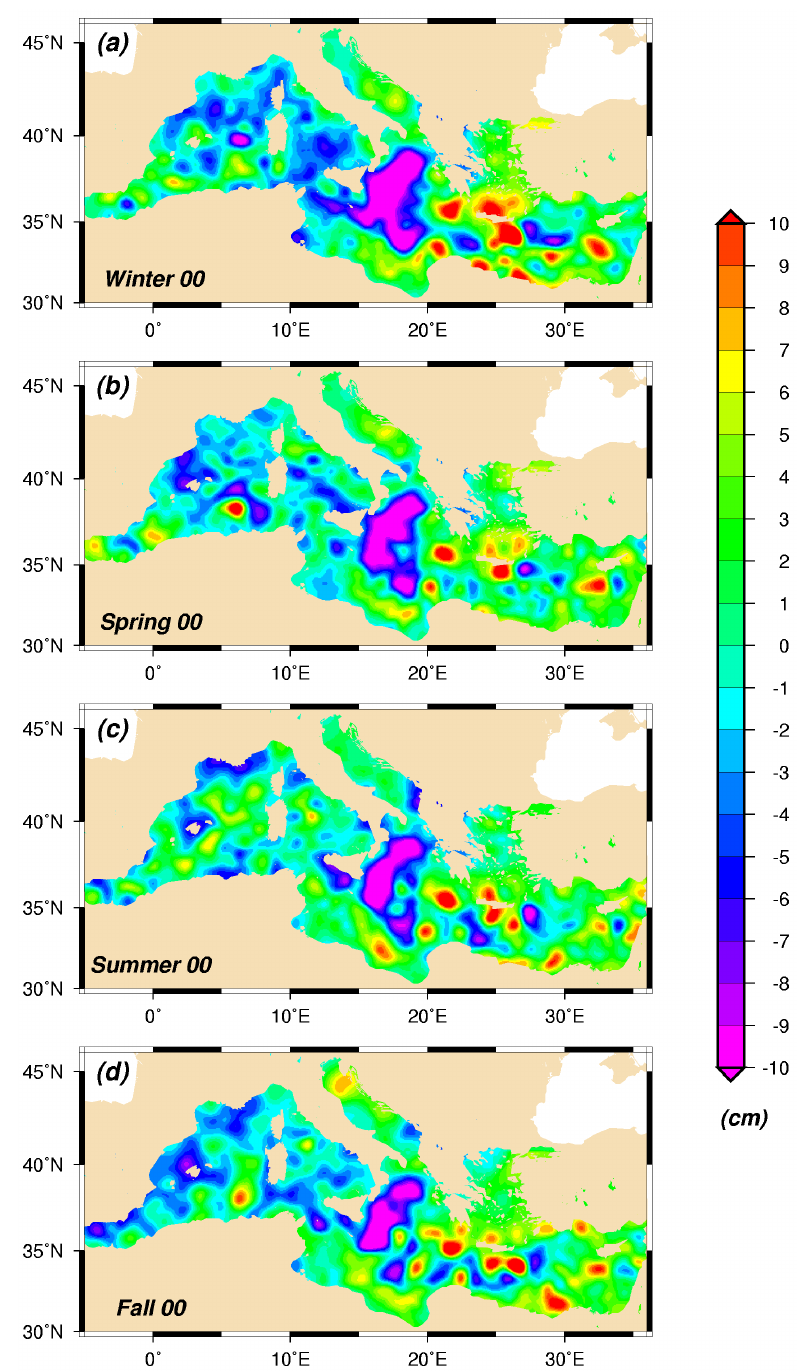
Fig. 3b. SLA seasonal means deduced from combined maps of T/P and ERS. Units are in cm. (a) Winter 2000, (b) Spring 2000, (c) Summer 2000, (d) Fall